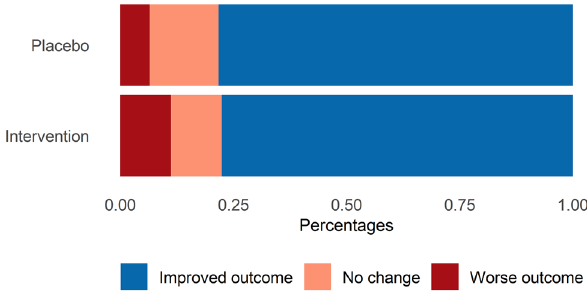
Figure 3. Clinical progression scale on individual level by 14 days.